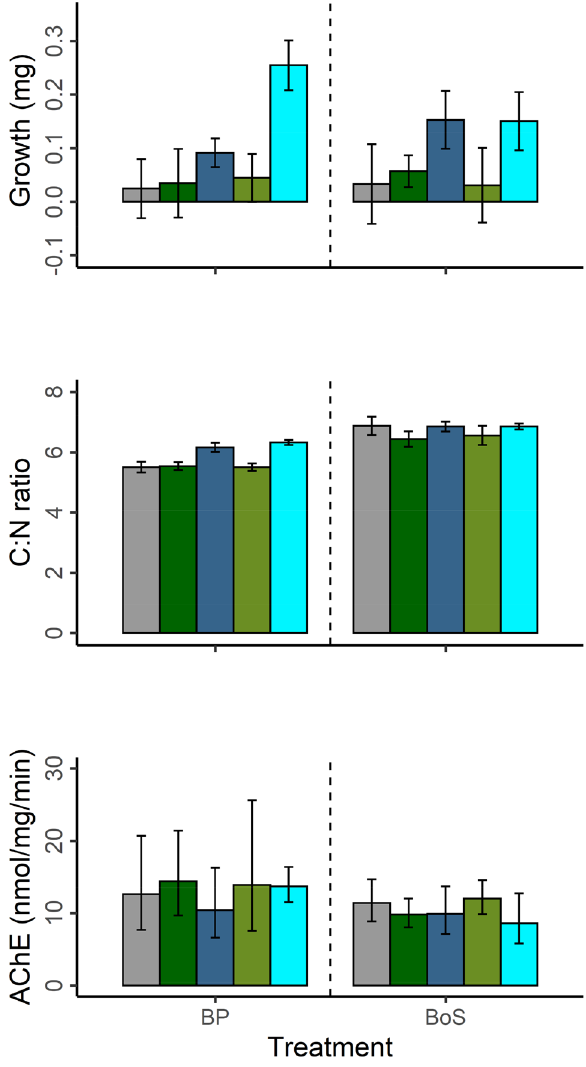
Figure 4. Body condition parameters (Growth and C:N ratio) and Acetylcholinesterase (AChE) activity for amphipods from each population and diet treatment. The diets include supplementation of the control sediment (S) with Low and High Diatom (LD, HD), and a combination of diatoms with low and high cyanobacteria (LDHC, HDLC). Colour represents each treatment: Control (grey), HD (green), HDLC (blue), LD (olive green), LDHC (turquoise). Values are mean ± SE for body conditions parameters and geometric mean [95% CI] for AChE activity. See Table 2 for statistical comparisons and Table S3, Supplementary Information: with absolute differences for the treatments under comparison.